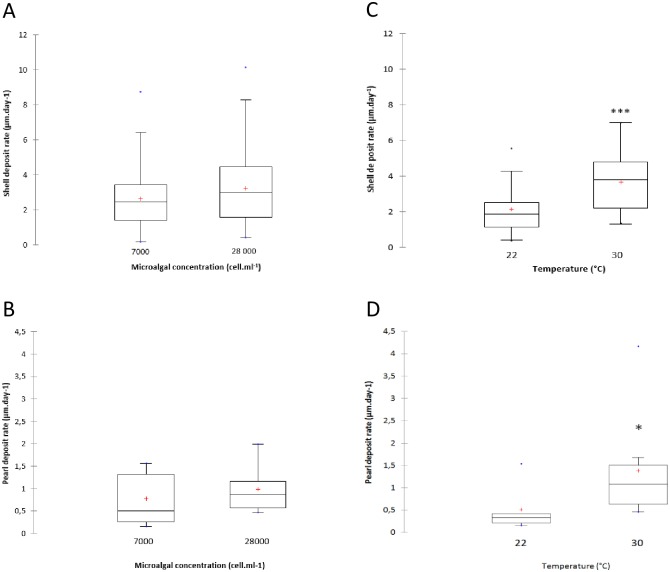
Mean shell and pearl deposition rate (SDR and PDR, μm day-1) in the pearl oyster Pinctada margaritifera after one month at different (A and B) microalgal concentrations and (C and D) water temperatures.Each plot includes mean (“+” cross in the box-plot), median (solid bar in the box-plot), 25th to 75th percentile represented in the rectangular box, 1.5×interquartile range (non-outlier range of the box whiskers), minimum and maximum values (extreme dots) and outlier values (outside box whiskers). Statistical analysis is based on the Student’s t-test. Statistical significance is indicated by asterisks as follows: *p < 0.05, **p < 0.01. (A: n = 88 and n = 87 for pearl oysters fed at 7000 cell mL-1 and 28,000 cell mL-1, respectively; C: n = 46 and n = 50 for pearl oysters subjected to 22°C and 30°C, respectively; and D: n = 9 per condition).